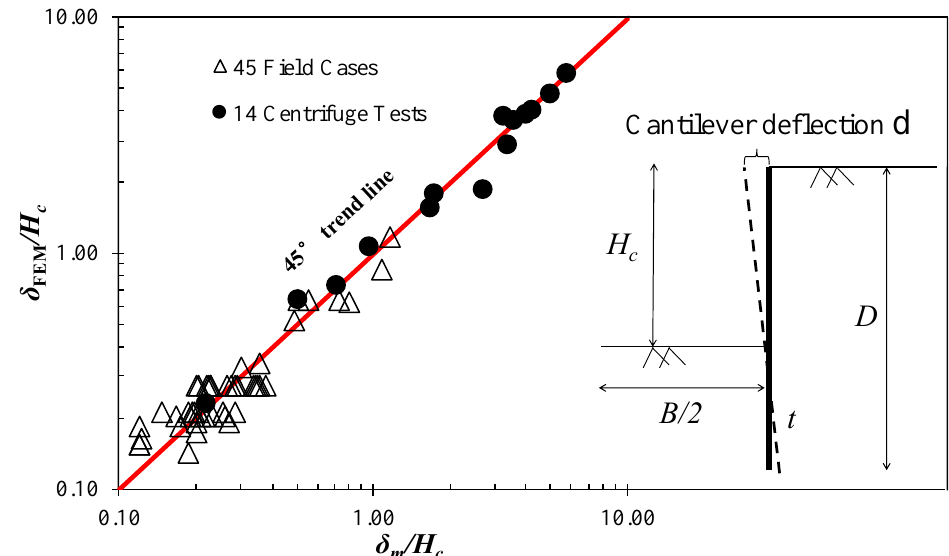
Figure 2. Cantilever wall deflections by Plaxis 2D versus measured values.